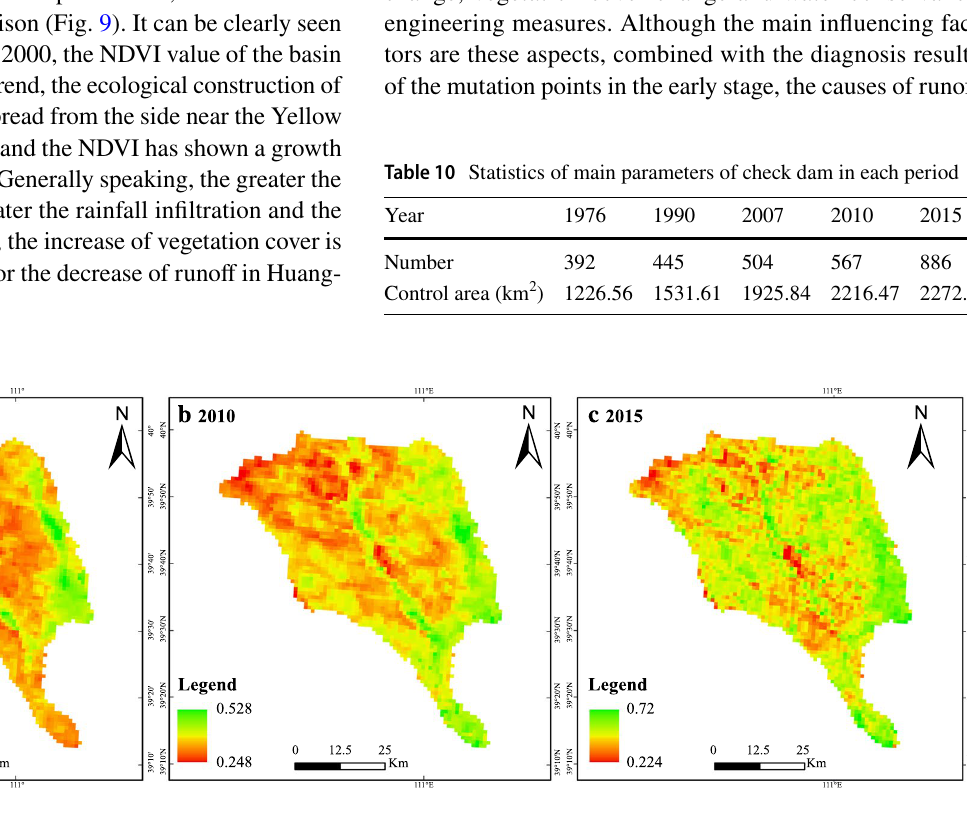
Fig. 9 Spatial distribution of NDVI in Huangfuchuan River basin in typical years